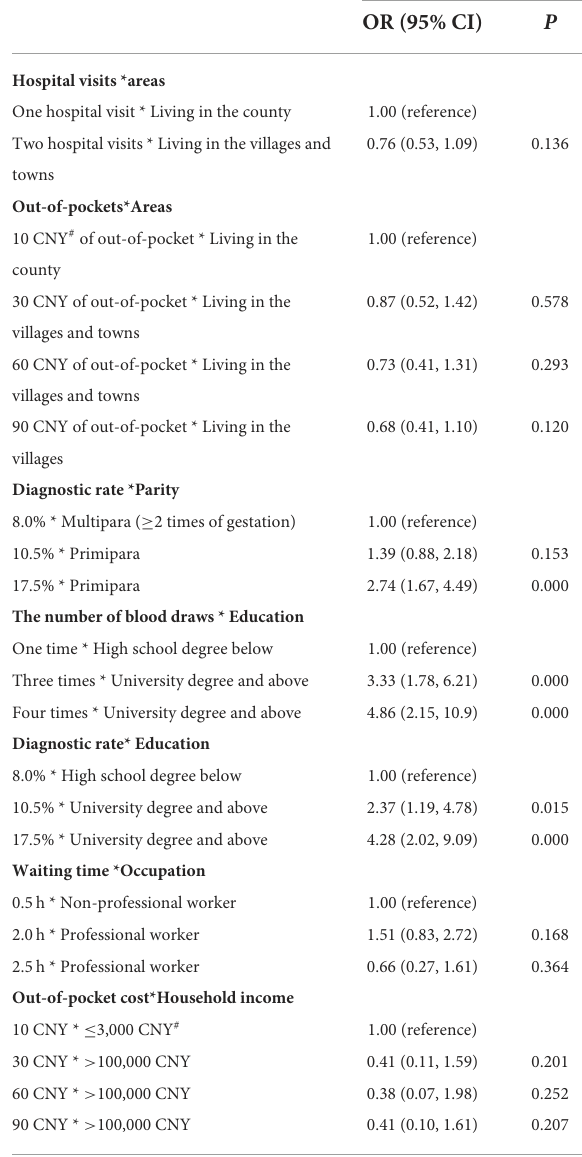
TABLE 4 Change (%) of uptake probabilities in attributes of GDM screening with observations = 4018. Changes from baseline